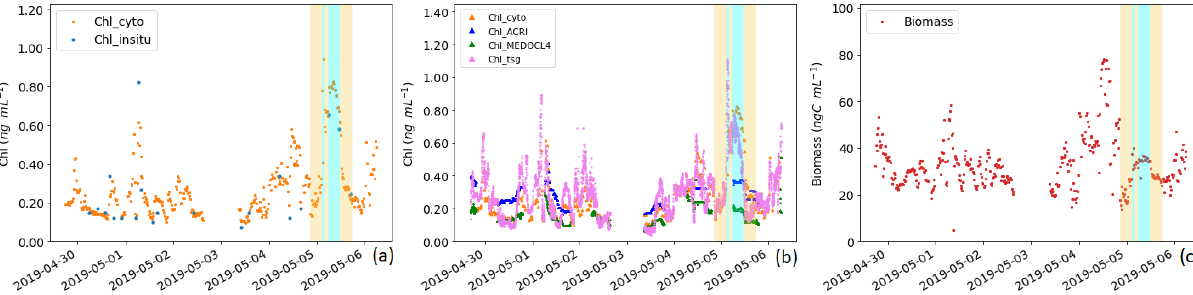
Figure 9. Panel (a) presents a comparison between the surface Chl- a concentration measured in situ (Chl_insitu,ngmL − 1 ) and the Chl- a con- centration estimation obtained from AFCM (Chl_cyto,ngmL − 1 ). Panel (b) presents a comparison between the surface Chl- a concentration estimated by AFCM (Chl_cyto), ACRI (Chl_ACRI), MEDOCL4 (Chl_MEDOCL4), and the fluorometer (Chl_tsg). Panel (c) shows the total surface phytoplankton biomass variation throughout the cruise (ngCmL − 1 ). The periods corresponding to the surface crossing of the newly mixed waters (in cyan) and the surrounding NC waters (6h before and after the newly mixed ones, in yellow) are indicated.